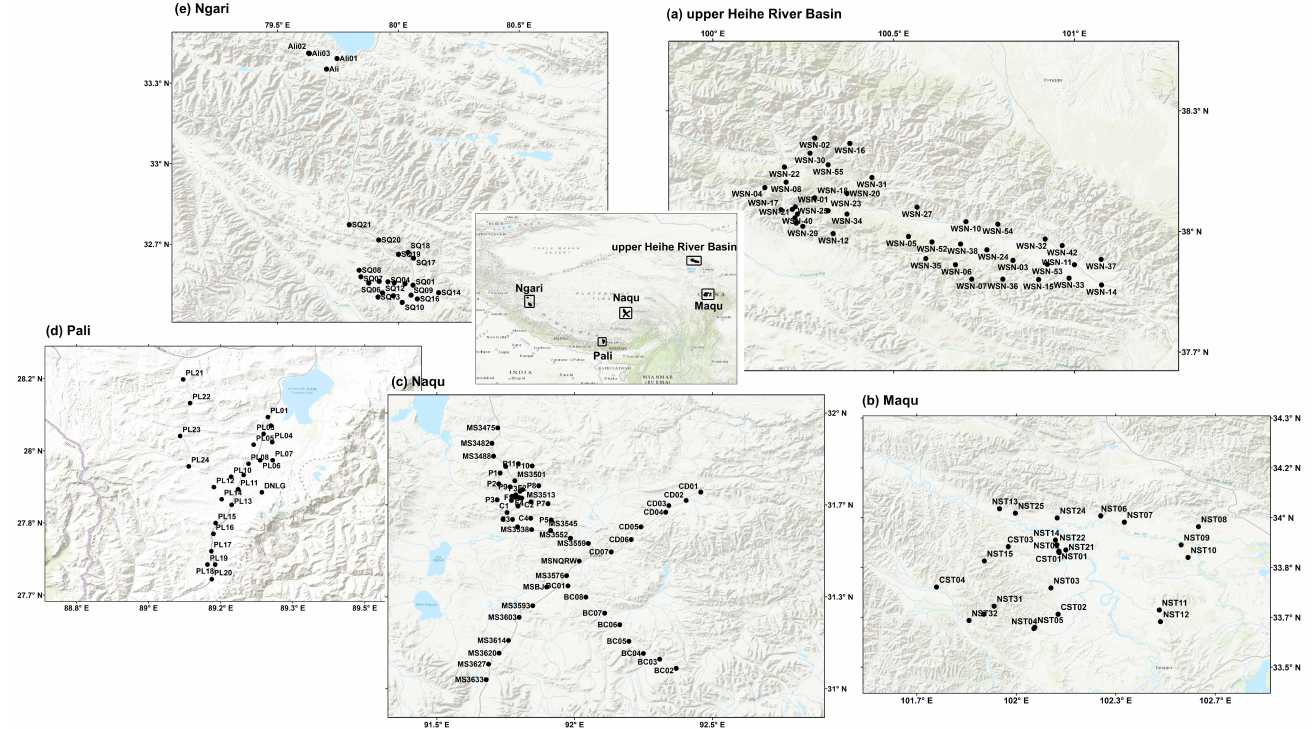
Figure 5. Locations of ( a ) upper Heihe River Basin, ( b ) Maqu, ( c ) Naqu, ( d ) Pali, and ( e ) Ngari SM observations networks and corresponding deployed SM observation stations on the